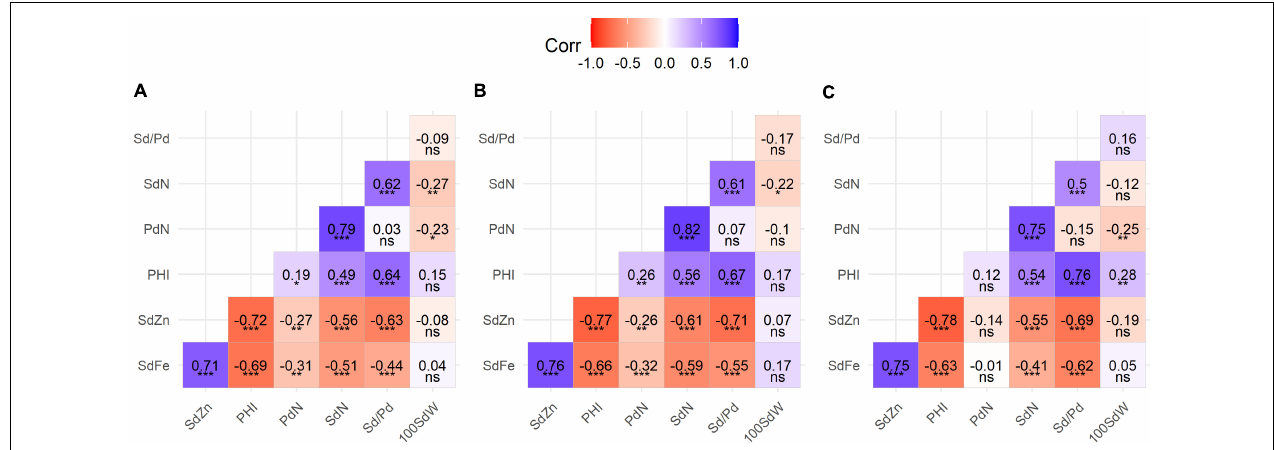
FIGURE 3 | Pearson’s correlation coefficients between yield components and mineral concentration traits on three populations: (A) SCR16 × SMC40, (B) SMC33 × SCR16, and (C) SMC44 × SCR9. Significance of correlations indicated as *** p < 0.0001; ** p < 0.001; * p < 0.01; ns, not significant. SdFe, seed iron; SdZn, seed zinc; PHI, pod harvest index; PdN, pod number; SdN, seed number; Sd/Pd, number of seeds per pod; 100SdW, 100 seed weight. Blue color indicates positive correlation and red color indicates negative